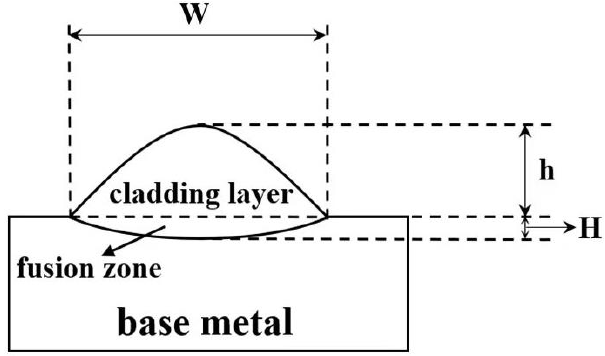
Figure 1. The schematic diagram of the dilution ratio calculation.